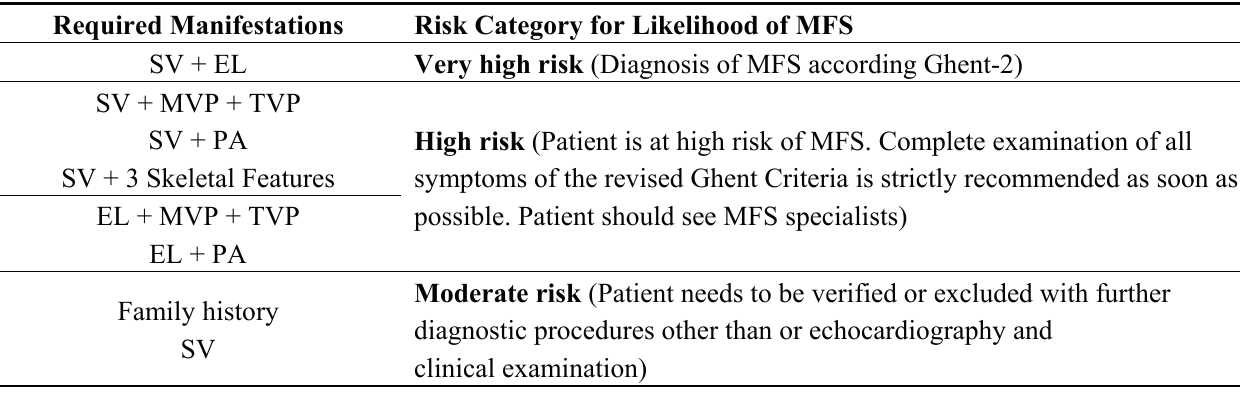
Table 2. Kid-Short Marfan Score (Kid-SMS)